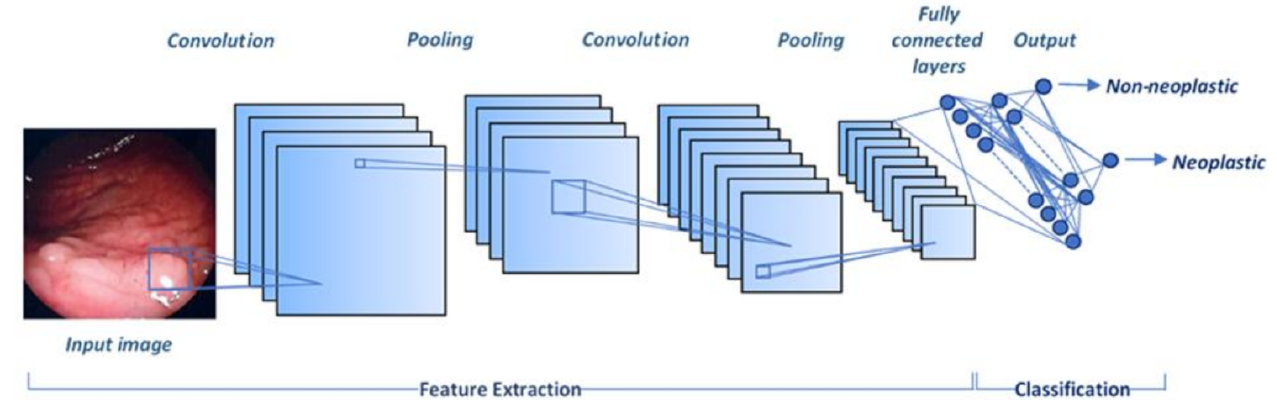
Figure 2. A convolutional neural network (CNN) design for colorectal polyp classification. CNN is a multilayer artificial neural network typically composed of three types of layers; convolution, pooling, and fully connected layers. Feature extraction from an input image is performed from the first two layers. The fully connected layers are used to map these features into a final output. CNN, convolutional neural